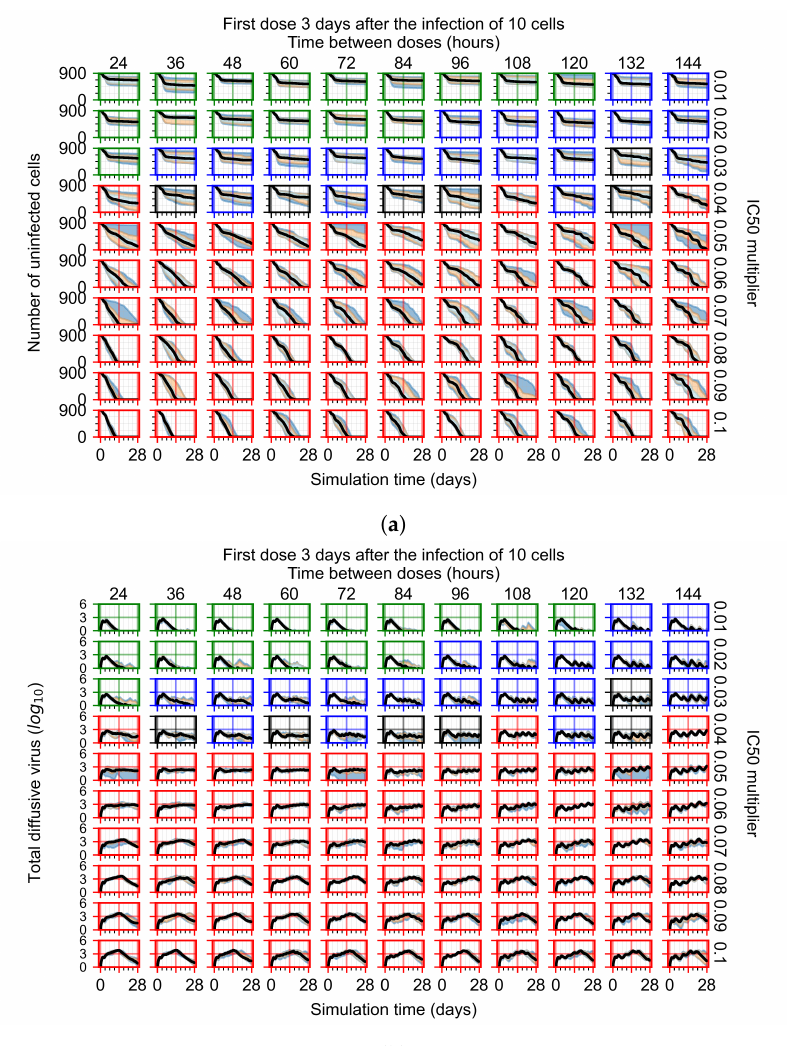
Figure 11. Extracellular diffusive virus populations for eight replicas of the treatment simulation. Epithelial cells’ metabolism and clearance varies from cell to cell. For all subfigures, the median measurement of simulation replicas is the black line, the 0th to 100th quantiles are shaded as dark blue, 10th to 90th shaded in orange, and 25th to 75th as light blue. Rapid clearance plot axis in green, slow clearance plot axis in blue, partial containment in black, and widespread infection in red. ( a ) Treatment starts with the infection of 10 cells. ( b ) Treatment starts three days post the infection of 10